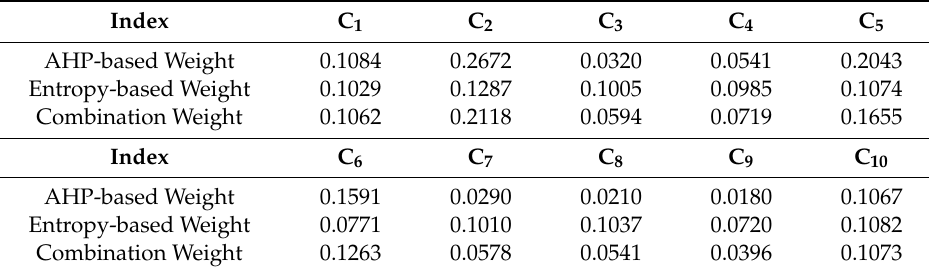
Table 5. Weights of the assessment indices of water